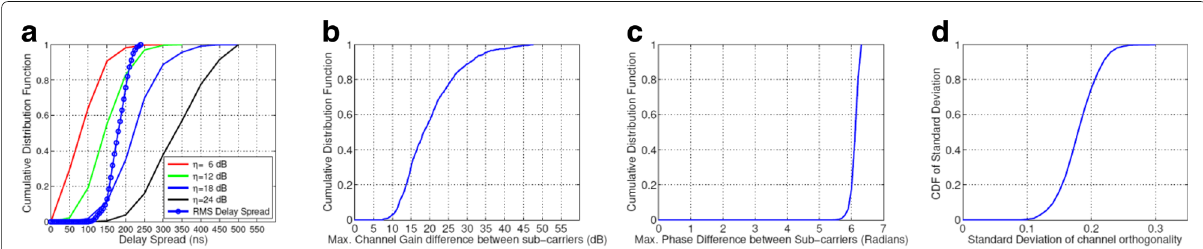
Fig. 3 Verifying impact of frequency selectivity on MU-MIMO performance on 5.2 GHz: a delay spread in an office environment, b maximum channel gain difference across all sub-carriers in an office environment, c maximum channel phase difference across all sub-carriers in an office environment, d channel orthogonality on different sub-carriers between 2